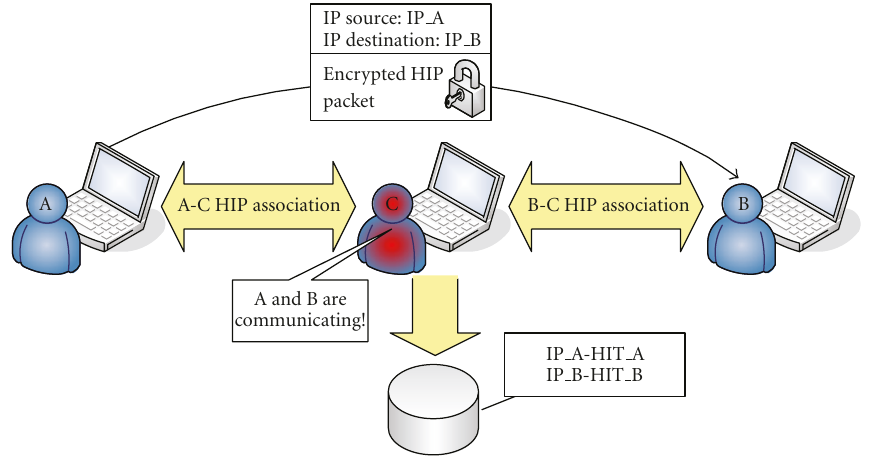
Figure 3: Anonymity loss with